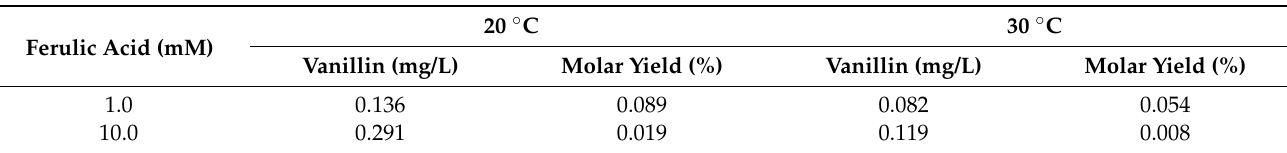
Table 5. Vanillin concentration and molar yield of transformation ferulic acid by purified KbLcc1 laccase (0.1 U) without the redox mediator.